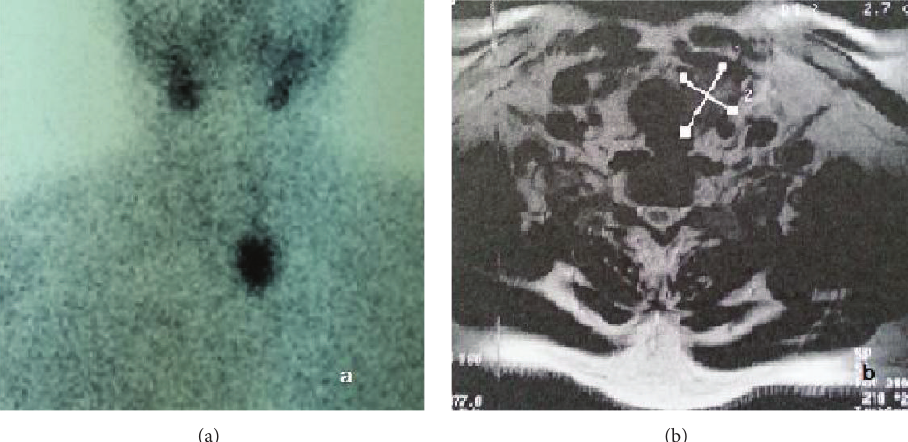
Figure 2: A 45-year-old man with parathyroid carcinoma: (a) Technetium-99m Sestamibi scan and (b) Magnetic Resonance Imaging scan showing the parathyroid